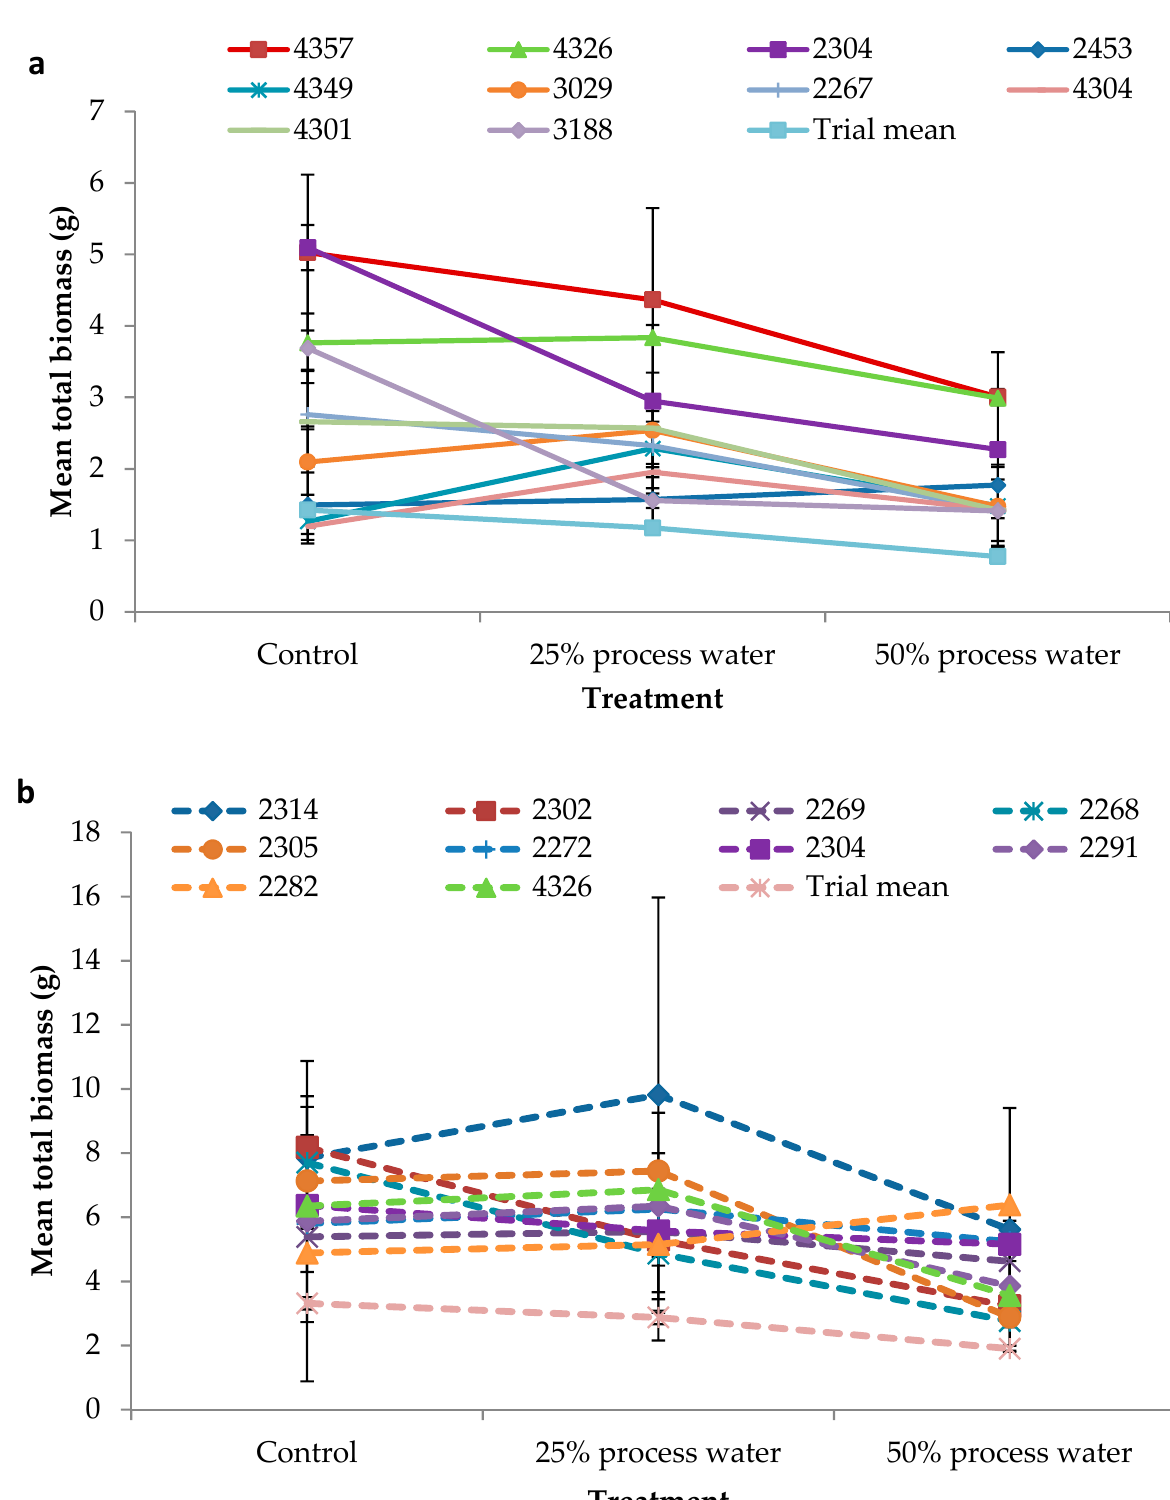
Figure 2. ( a ) Total biomass (mean dry weight ± SE) in each water treatment for the top 10 balsam poplar clones in the three water treatments and the overall means for all trees after 44 days of growth in the 2012 experiment (solid line). ( b ) Total biomass (mean dry weight ± SE) vs. treatment for the top 10 balsam poplar clones in the control, 25%, and 50% process water treatment solutions and the overall treatment mean after 65 days of growth in the 2013 experiment (dash line). Clones tested in both years (4326 and 2304) are in the same colour.